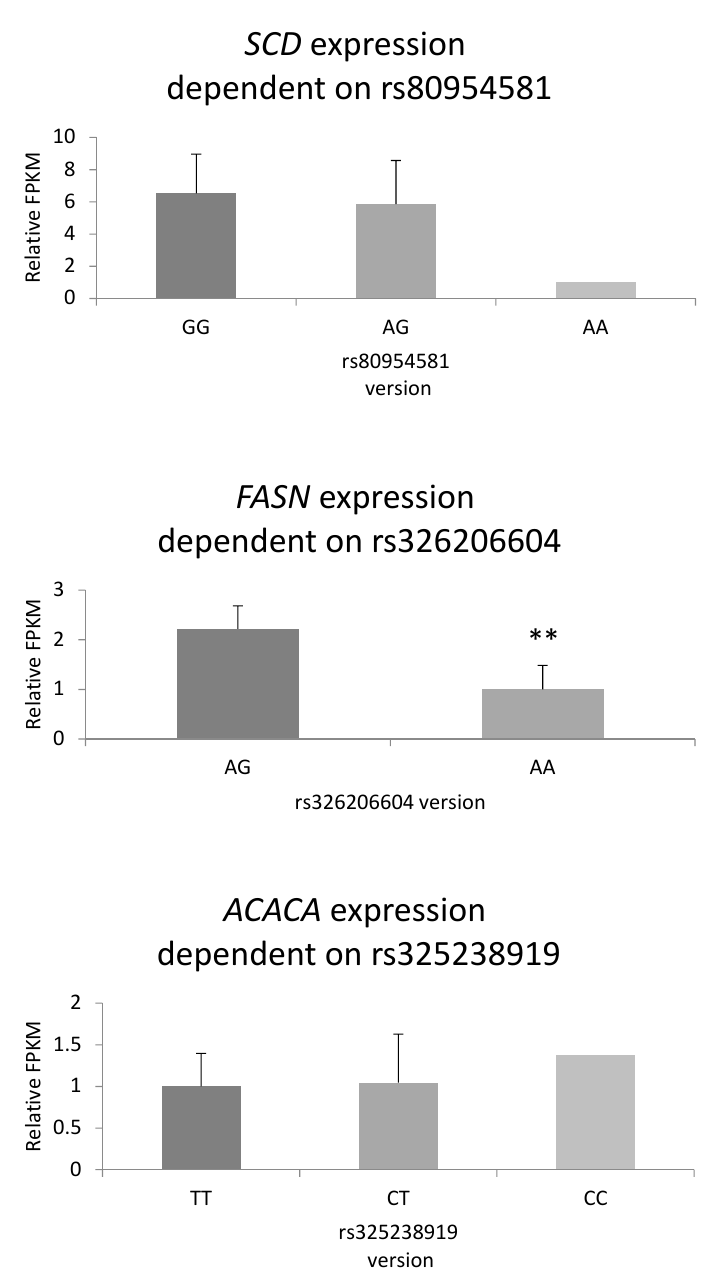
Figure 2. The expression pattern for FASN, SCD, and ACACA genes in backfat tissue depending on their mutation variants for Puławska breed. The expression was estimated based on Fragments Per Kilo Base of exon model per million reads mapped